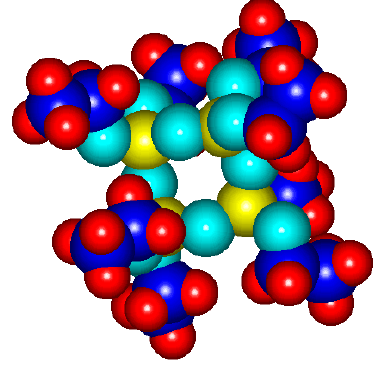
Figure 1. Legend: Si: yellow, O: cyan, C: blue, and H: